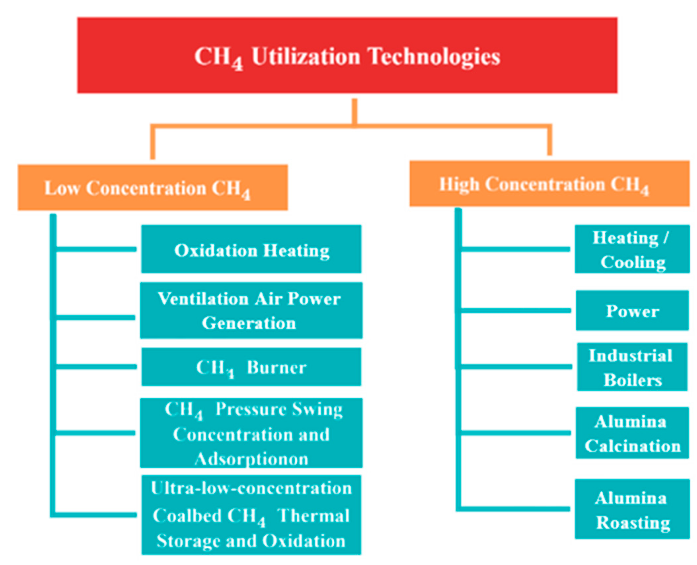
Figure 9. CBM utilization technologies with good technical prospects.